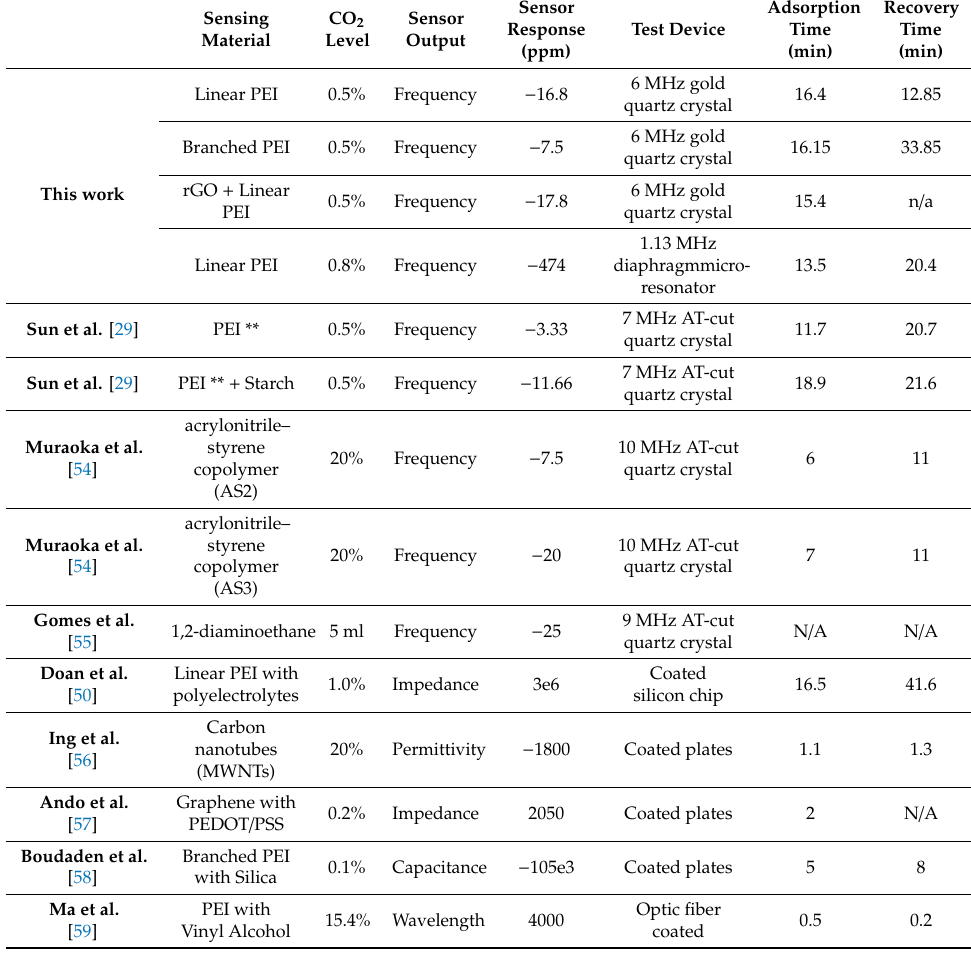
Table 6. Comparison of the studied CO 2 adsorbing coatings with other published